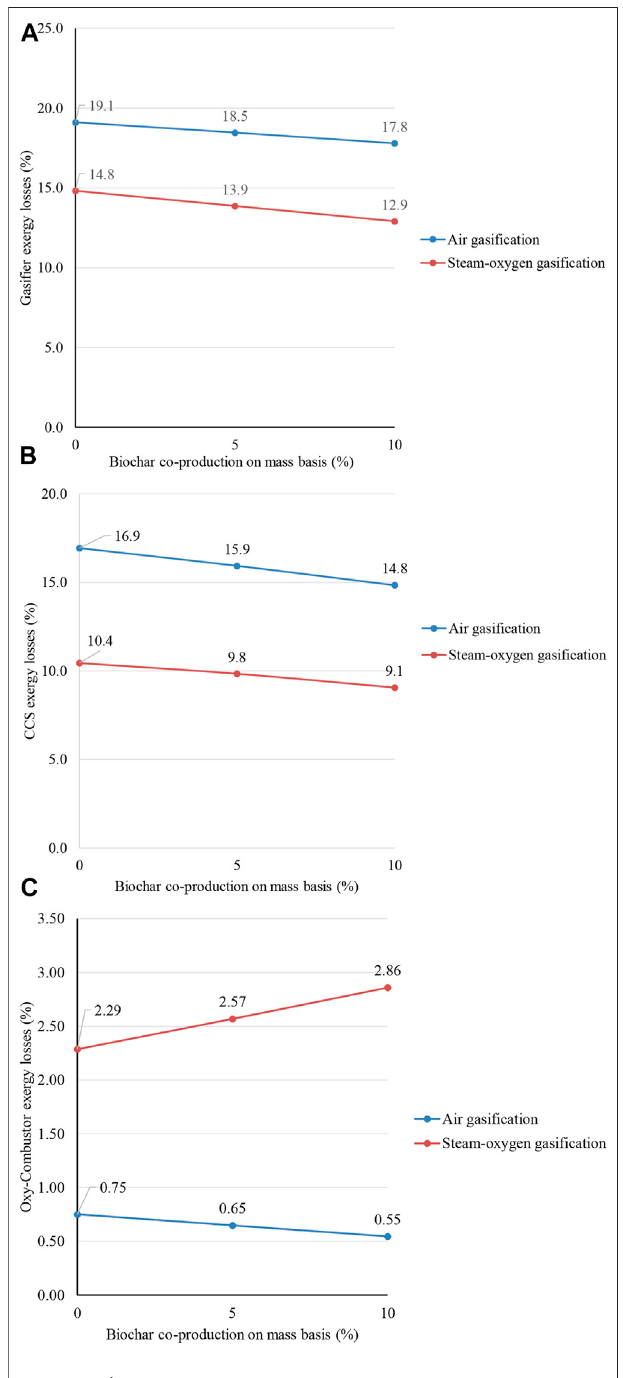
fi er exergy loss. (B) Effect of biochar co-production on the CCS exergy loss. (C) Effect of biochar co-production on oxy-fuel combustor exergy